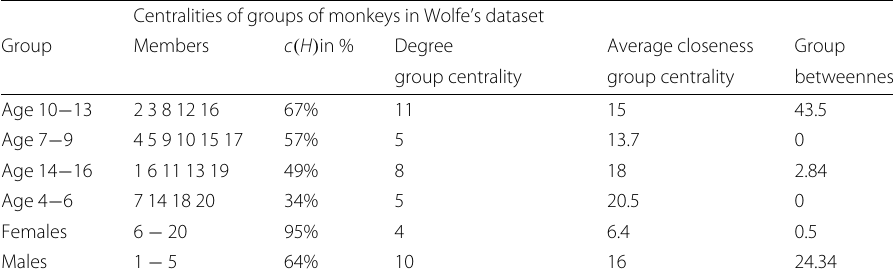
Borgatti 1999) and the centrality c ( H ) . The centrality values for c ( H ) are given here in % as they give the proportions of all successions of interactions between monkeys involving at least one member of the group. The centralities c ( H ) were computed by the FlowFraction algorithm available on the Matlab File Exchange (Giscard and Wilson